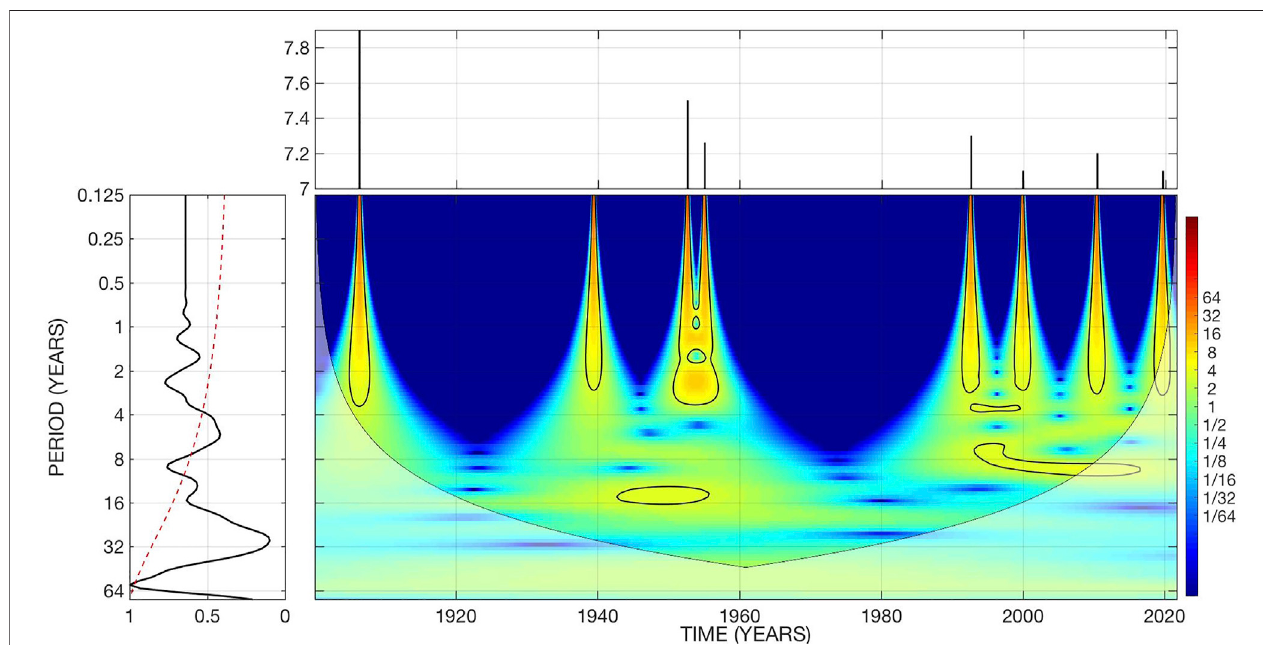
FIGURE 2 | Results of the time-frequency wavelet spectral analysis of earthquake time series record ( M ≥ 7) for the southwestern United States and northern Mexico seismic zone between 1900 and 2021. The global time-averaged wavelet period (left panel) with the red dashed line indicating the 95% con fi dence level drawn from a red noise spectrum. The Morlet wavelet power spectral density (MWPSD) in arbitrary units adopting the red-green-blue colour scales (central panel). The cone of in fl uence shows the possible edge effects in the MWPSD (i.e., the U-shaped curves outside of which the spectral information can be considered unreliable).